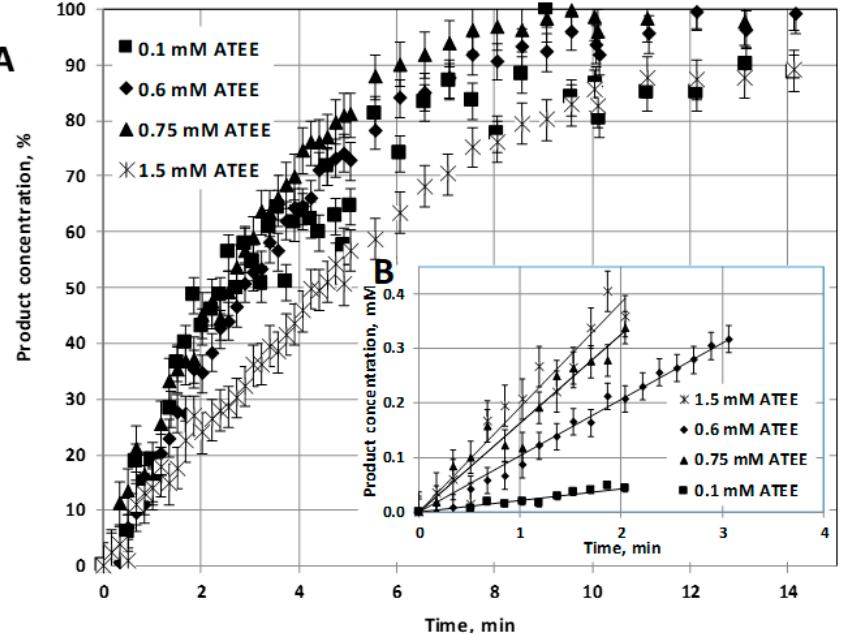
Figure 3. ( A ) Substrate conversion (%) plotted as a function of time; ( B ) calculation of initial reaction rate values ( v o ) during the kinetic measurement. v o values can get as a slopes of lines which are plotted as linear regression of product concentration values as a function of time during the initial time period of biochemical reaction (e.g., during the first 2 min). Product concentration values are calculated from absorbance values of 3 mL reaction mixture in a quartz cuvette (with 1 mg / L α -chymotrypsin and at di ff erent substrate concentrations). (Standard error values are plotted. They have varied between 4% and